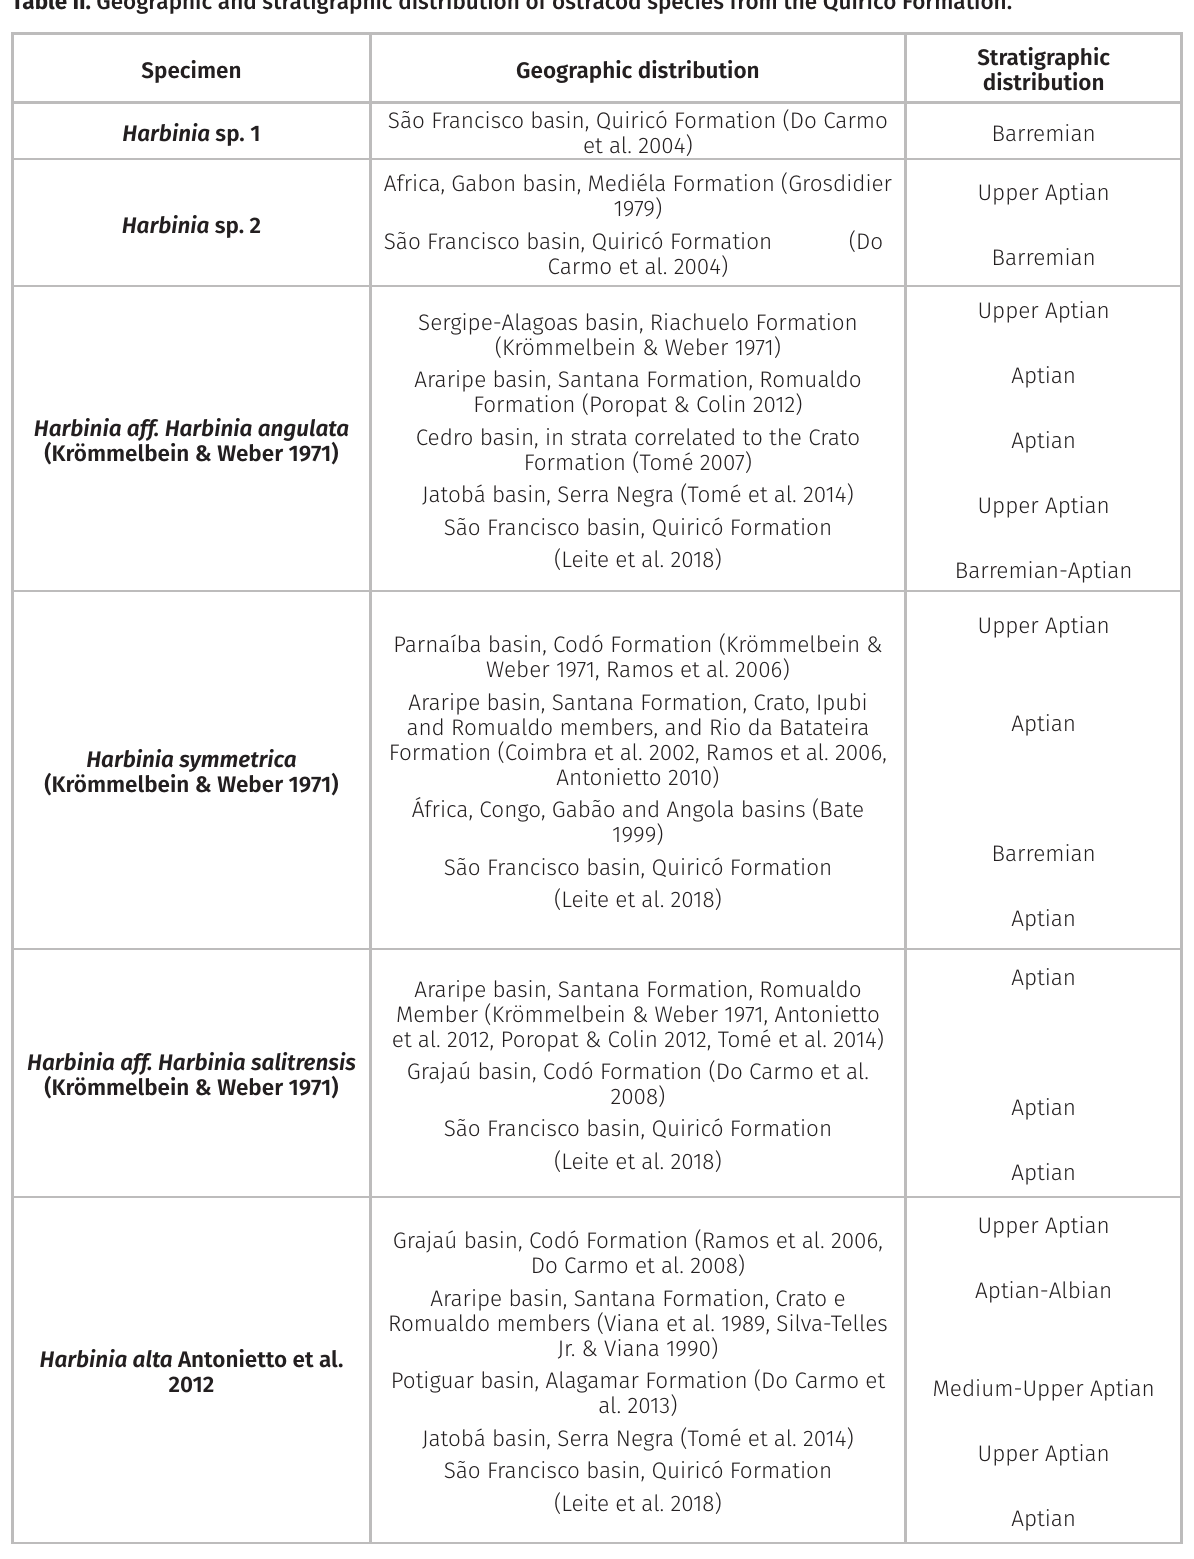
Table II. Geographic and stratigraphic distribution of ostracod species from the Quiricó